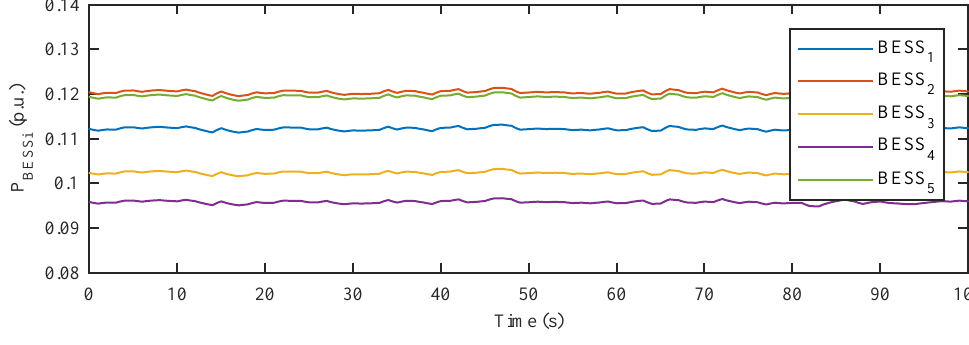
Figure 19. Power output of the